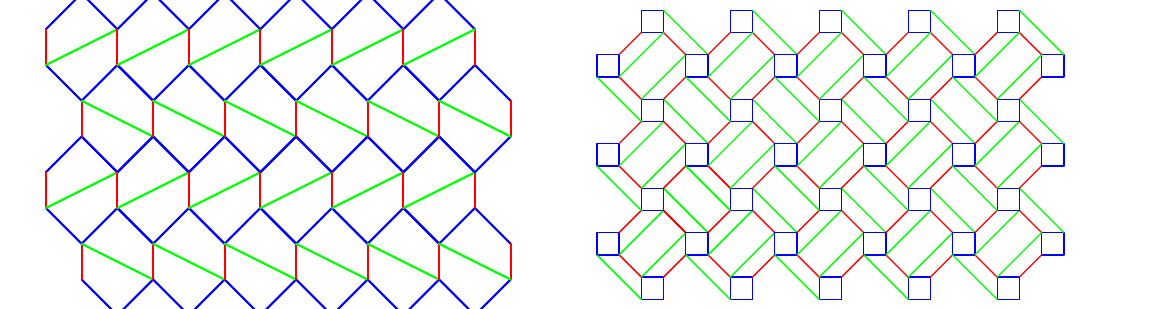
Fig. 32: Tiling with equal quadrilaterals with reflections.